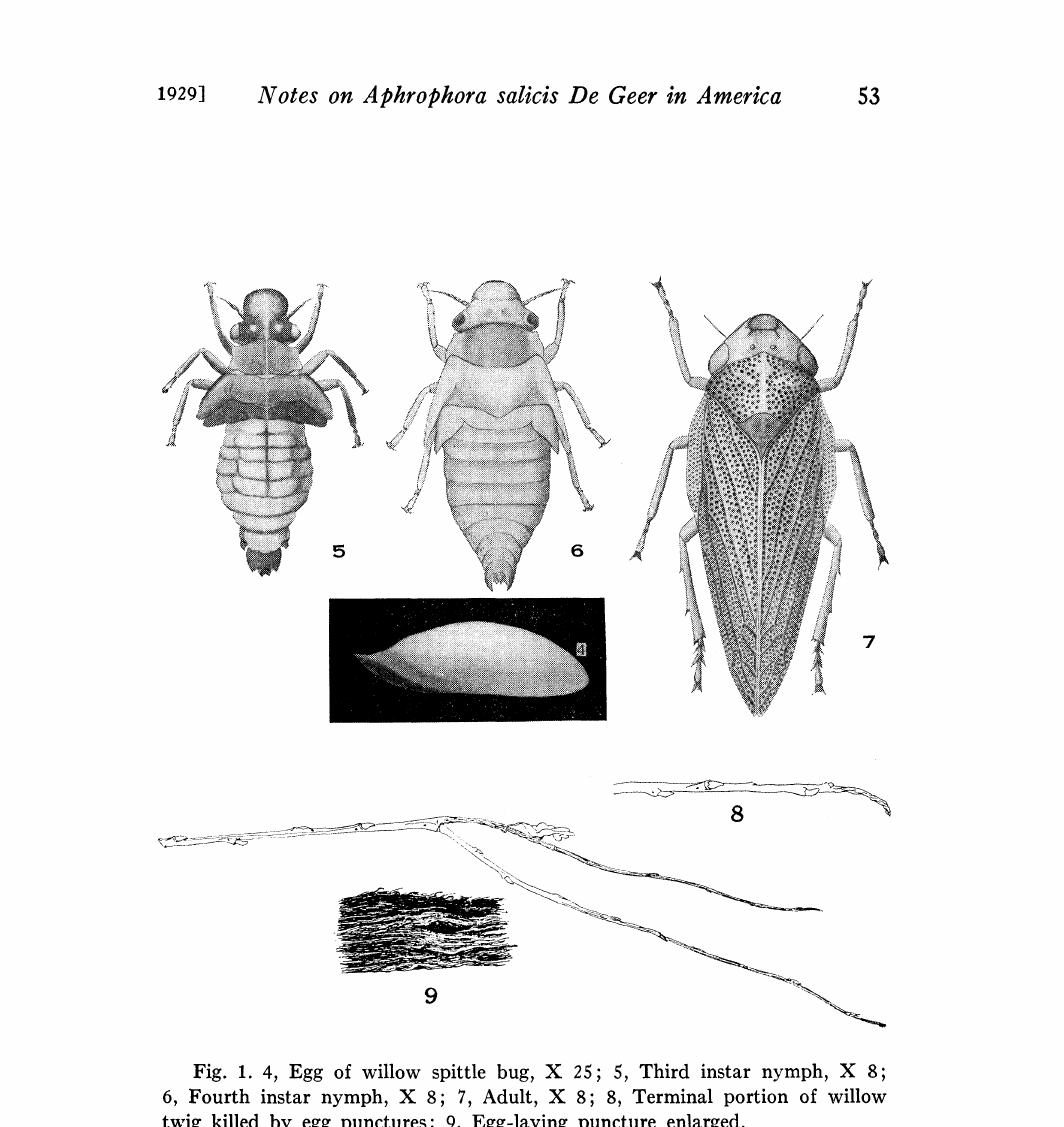
Fig. 1. 4, Egg of willow spittle bug, X 25; 5, Third instar nymph, X 8; 6, Fourth instar nymph, X 8; 7, Adult, X 8; 8, Terminal portion of willow twig killed by egg punctures; 9, Egg-laying puncture